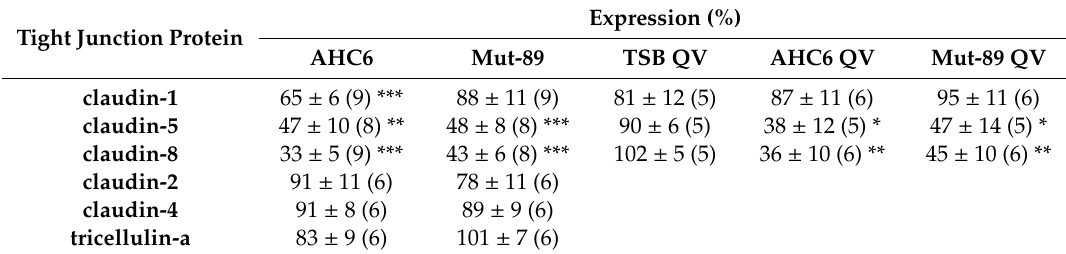
Table 2. Densitometric quantification of tight junction protein expression (mean ± SEM ( n ), values are given in % of TSB-treated control, which was set to 100%, * p < 0.05; ** p < 0.01; *** p < 0.001 versus TSB control). QV